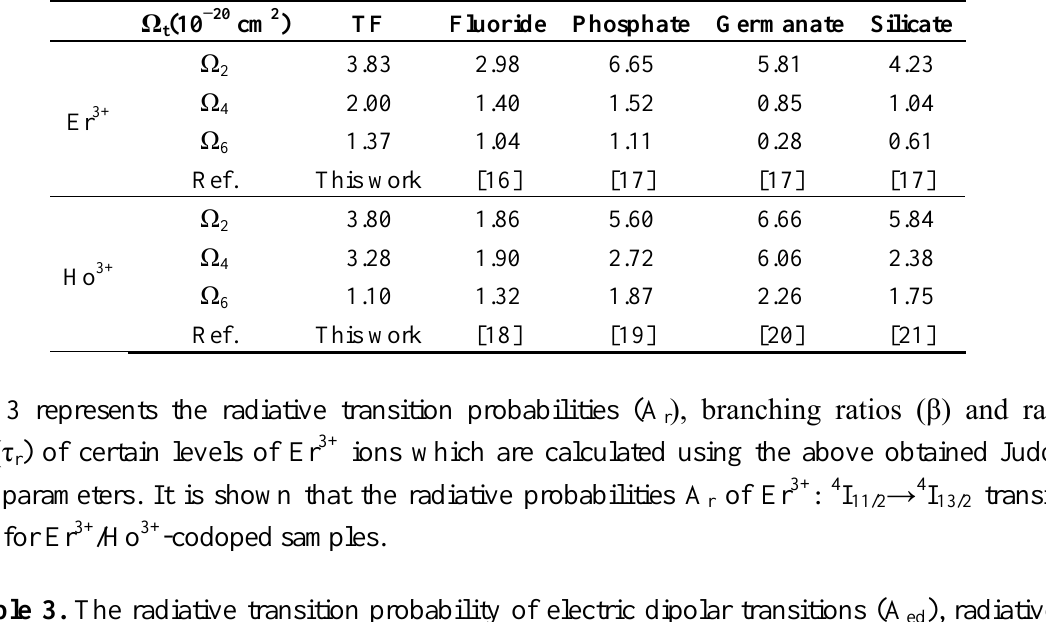
), radiative ed ), branching ratio (β) and md